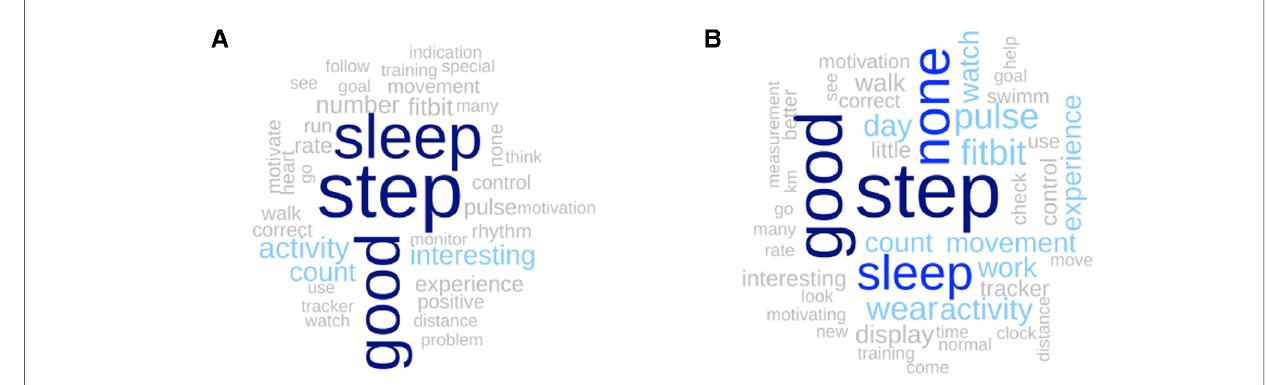
FIGURE 3 Word cloud of the words appearing at least three times in the weekly answers to the question “ what was your experience with activity trackers this week? ” asked during the rehabilitation phase (Panel A, n answers=107) and during the home phase (Panel B, n answers=142). See Supplementary Figures AS2, AS3 in the Supplementary Appendix for more details about the frequency of the